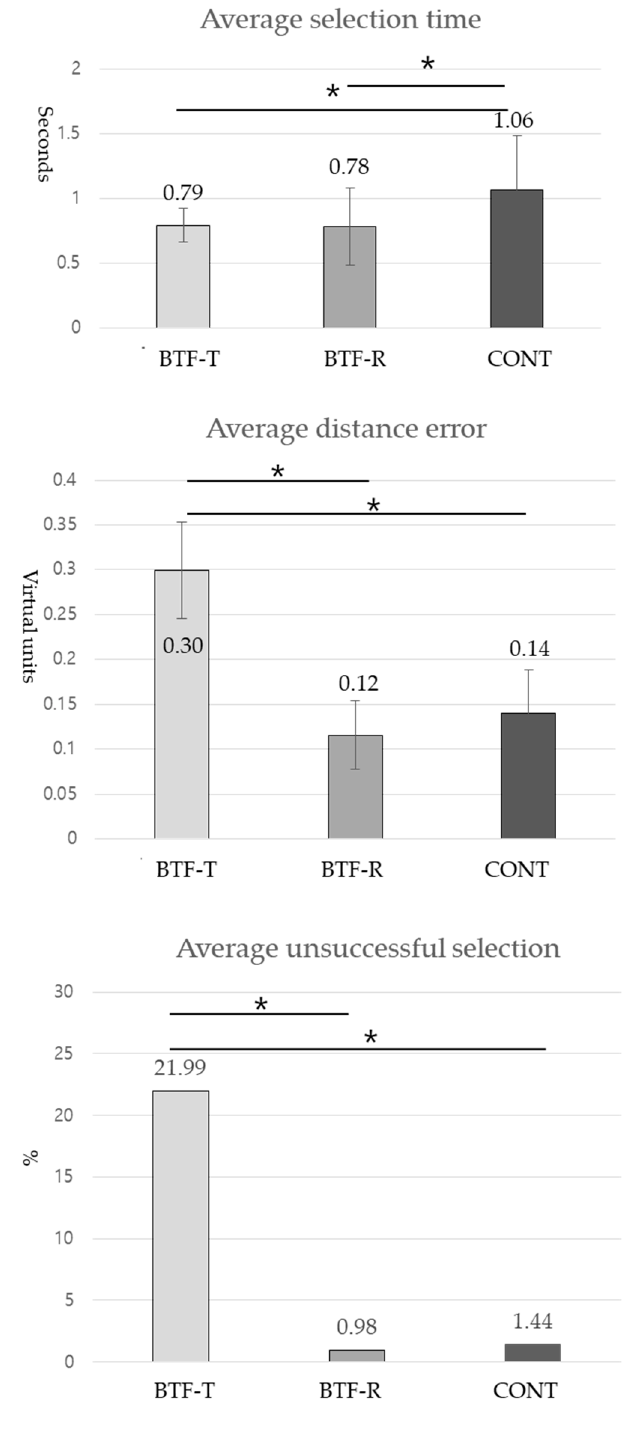
Figure 8. Quantitative performance measures (average selection time, average distance error and average number of unsuccessful selections in percentage) among the three interface types. The asterisk mark (*) indicates statistically significant difference.